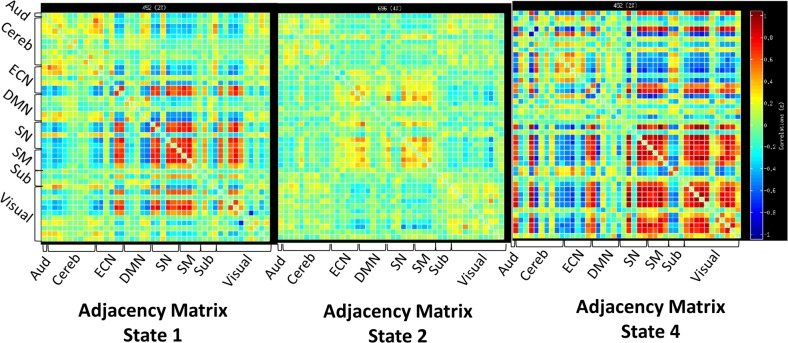
Adjacency matrices for network states 1, 2, and 4.Adjacency matrices for states 1, 2, and 4 which appeared only in the TBI sample. Abbreviations: Aud: auditory network, ECN: executive control network, DMN: default mode network, SM: sensory-motor network, SN: salience network.